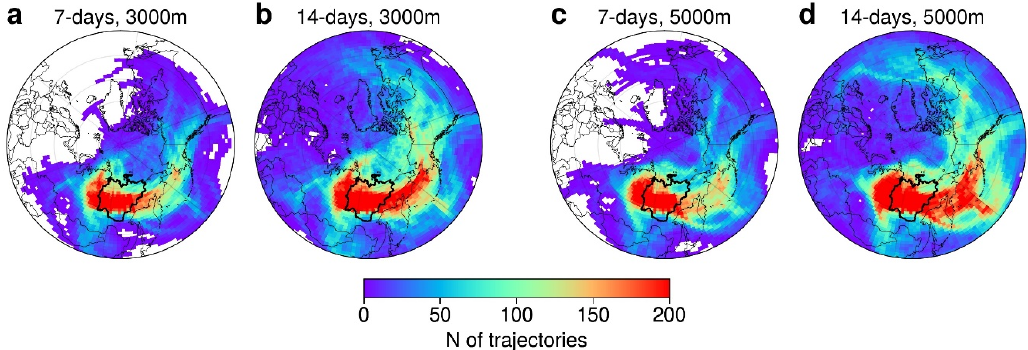
Figure 12. The number of HYSPLIT forward trajectories from 26 July to 15 August originated from 36 starting points evenly spaced over the study region (1.4° × 6° lat/lon). Trajectories forward runtime and starting altitudes are: ( a ) 7 days, 3000 m; ( b ) 14 days, 3000 m; ( c ) 7 days, 5000 m; ( d ) 14 days, 5000 m. The bold solid line indicates Yakutia’s administrative boundary.